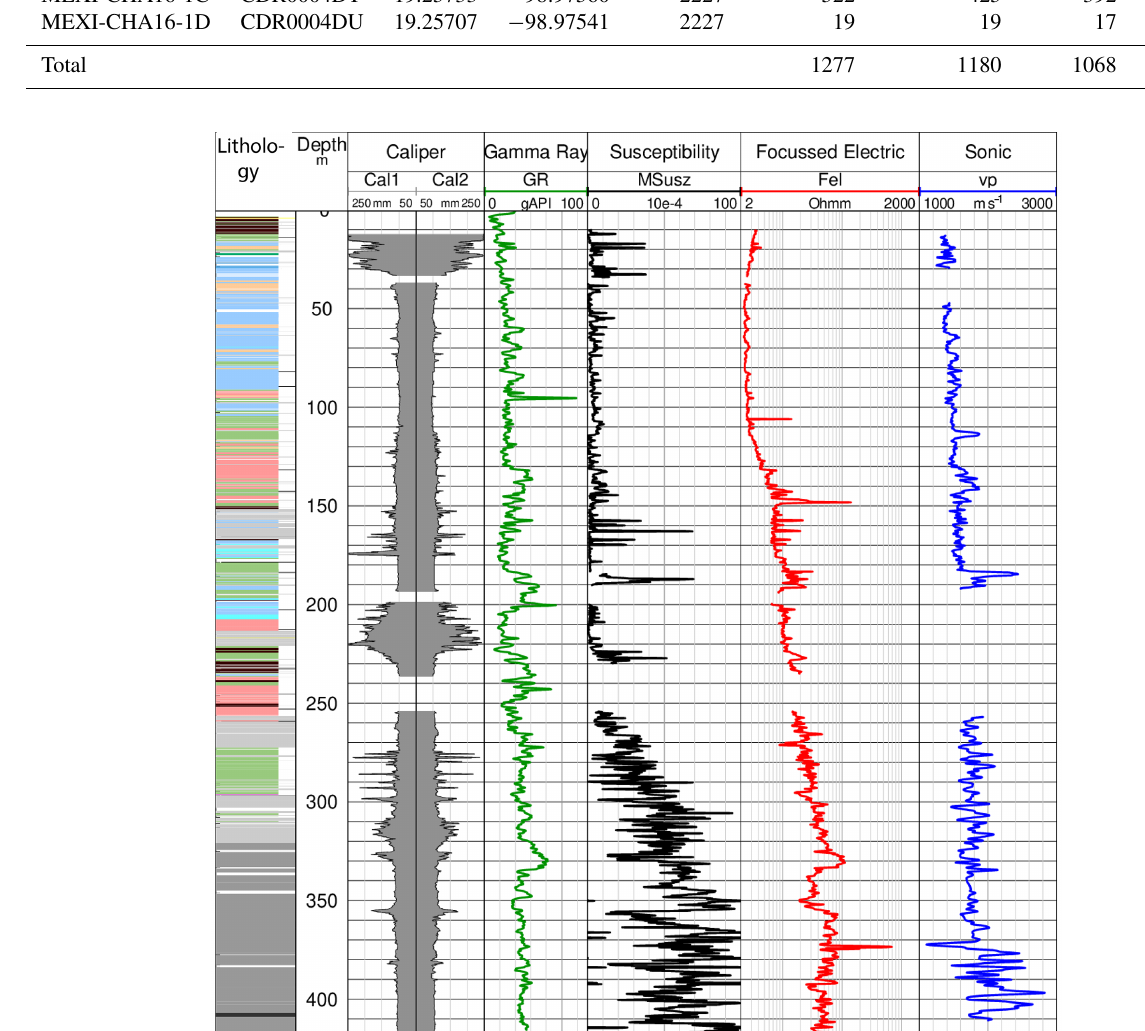
Figure 5. Downhole logging data of the 1A borehole: Cal1 and Cal2 – caliper (in millimeters); GR – gamma ray; MSusz – microsuscepti- bility; Fel – focussed electric resistivity; vp – compressional velocity; lithology from core. Lithology legend in Fig. 8.